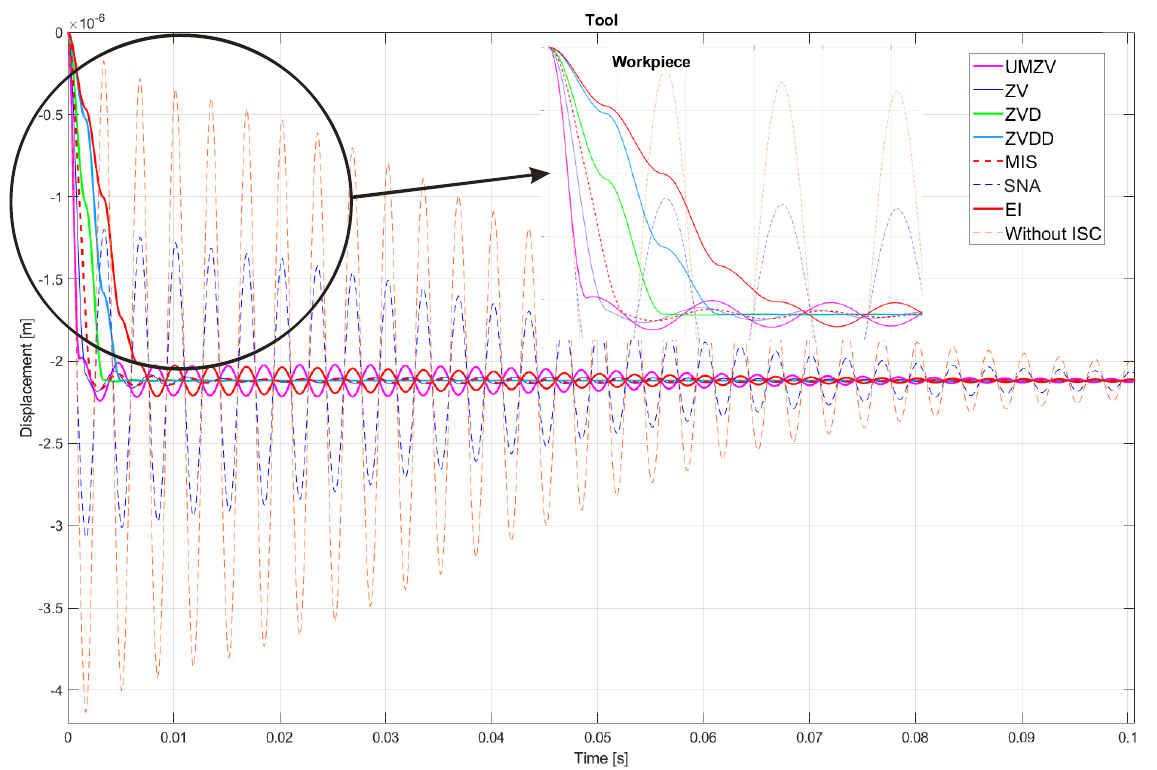
Figure 9. Work piece displacement during finishing machining: without ISC control, using UMZV, ZV, ZVD, ZVDD, MIS, SNA and EI algorithm.